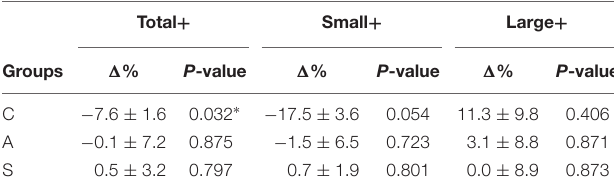
TABLE 4 | Whole trigeminal